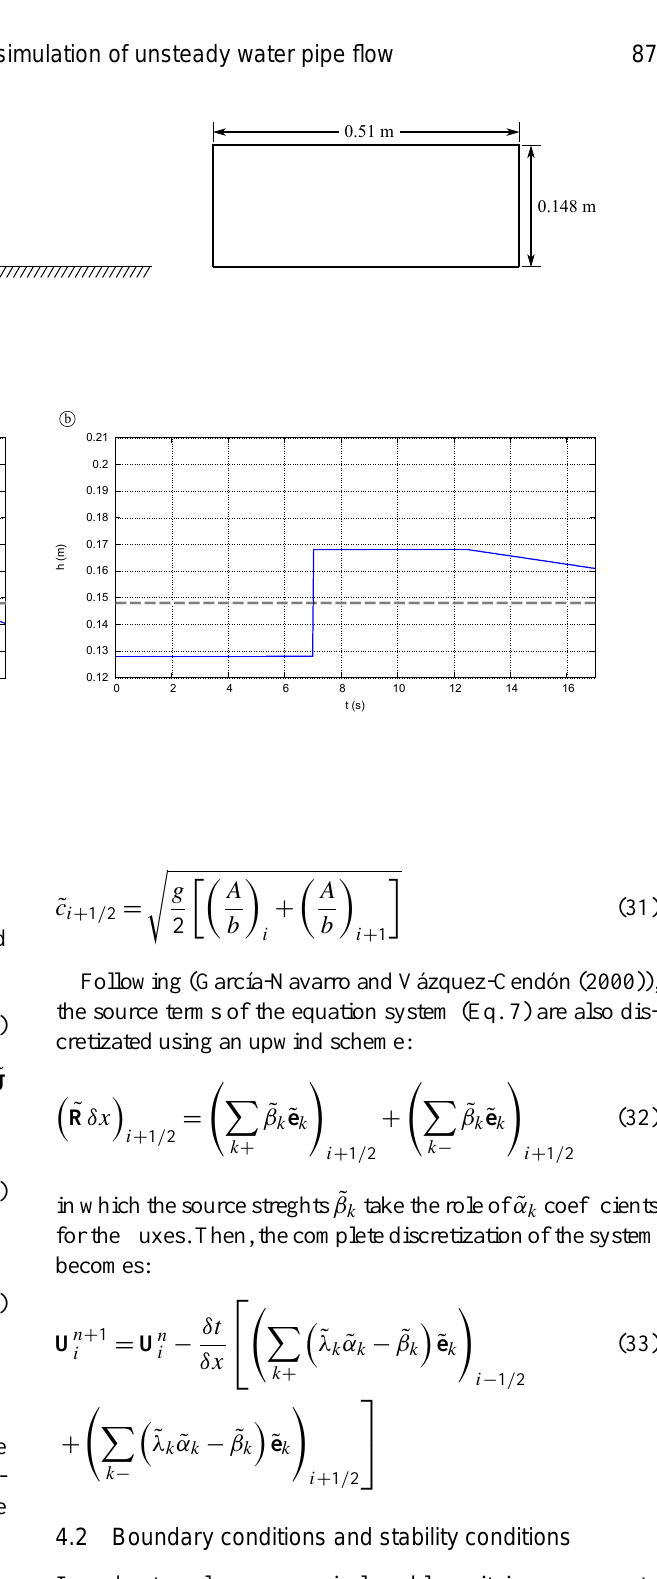
1.0 Figure 5. Dam-break test case. Initial state (dashed line). Numerical results (blue dots). Analytical solution (cyan line).